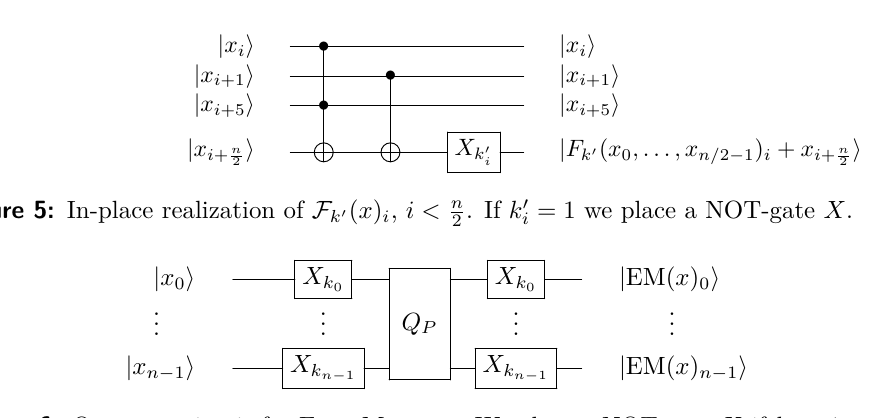
Figure 6: Quantum circuit for Even-Mansour. We place a NOT-gate X if k i = 1.